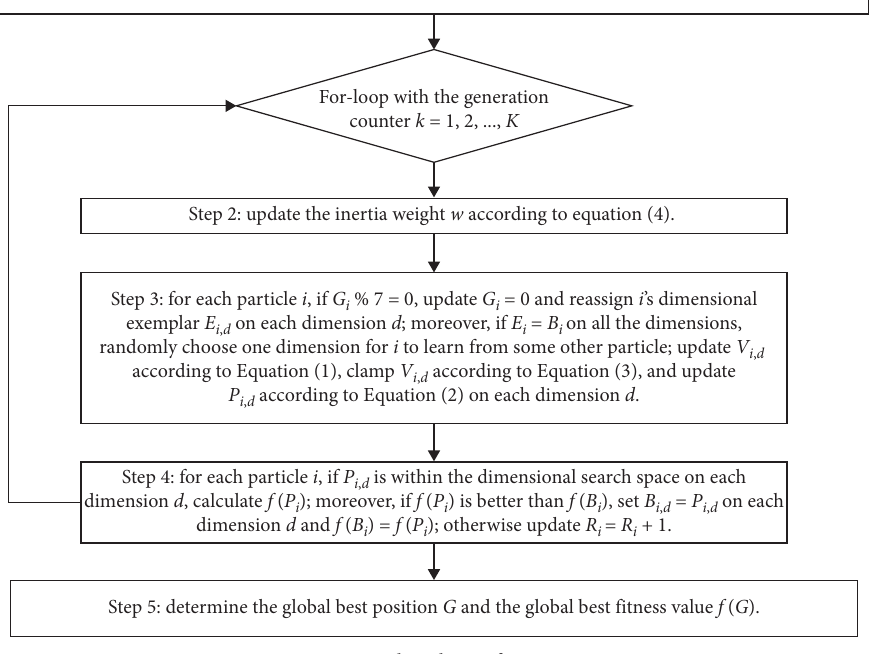
Figure 1: Flowchart of